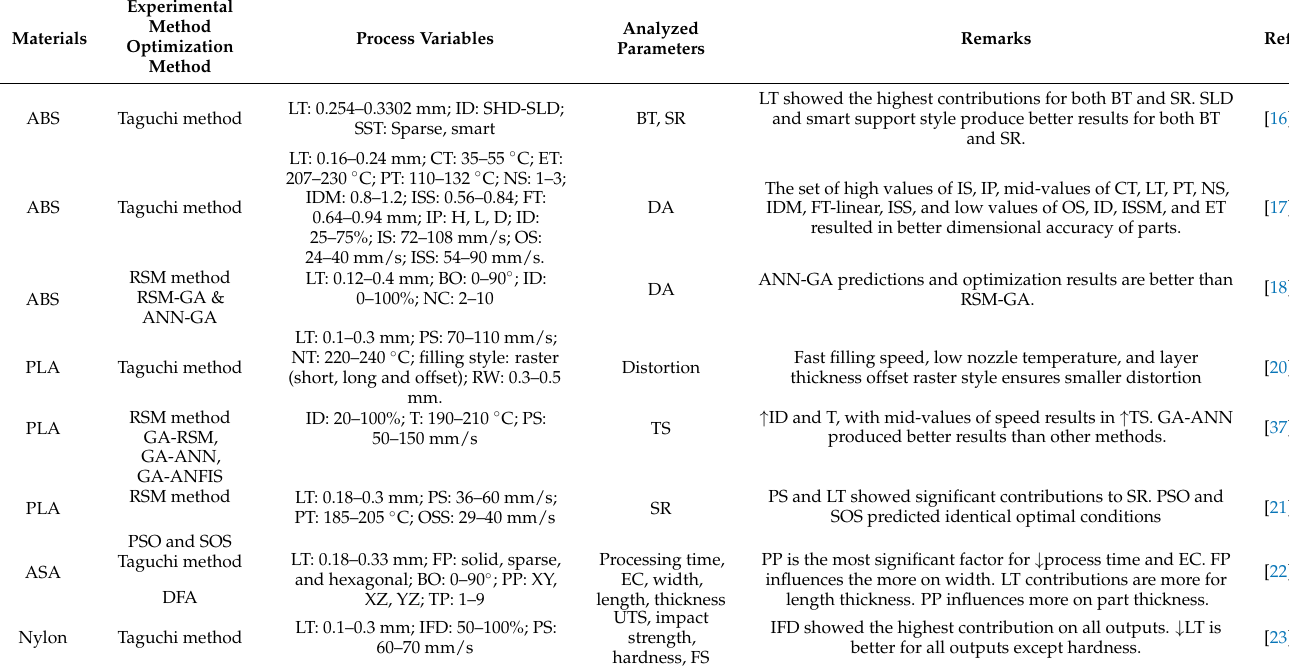
Table 1. Summary of literature review of FDM process parameters and their optimization.